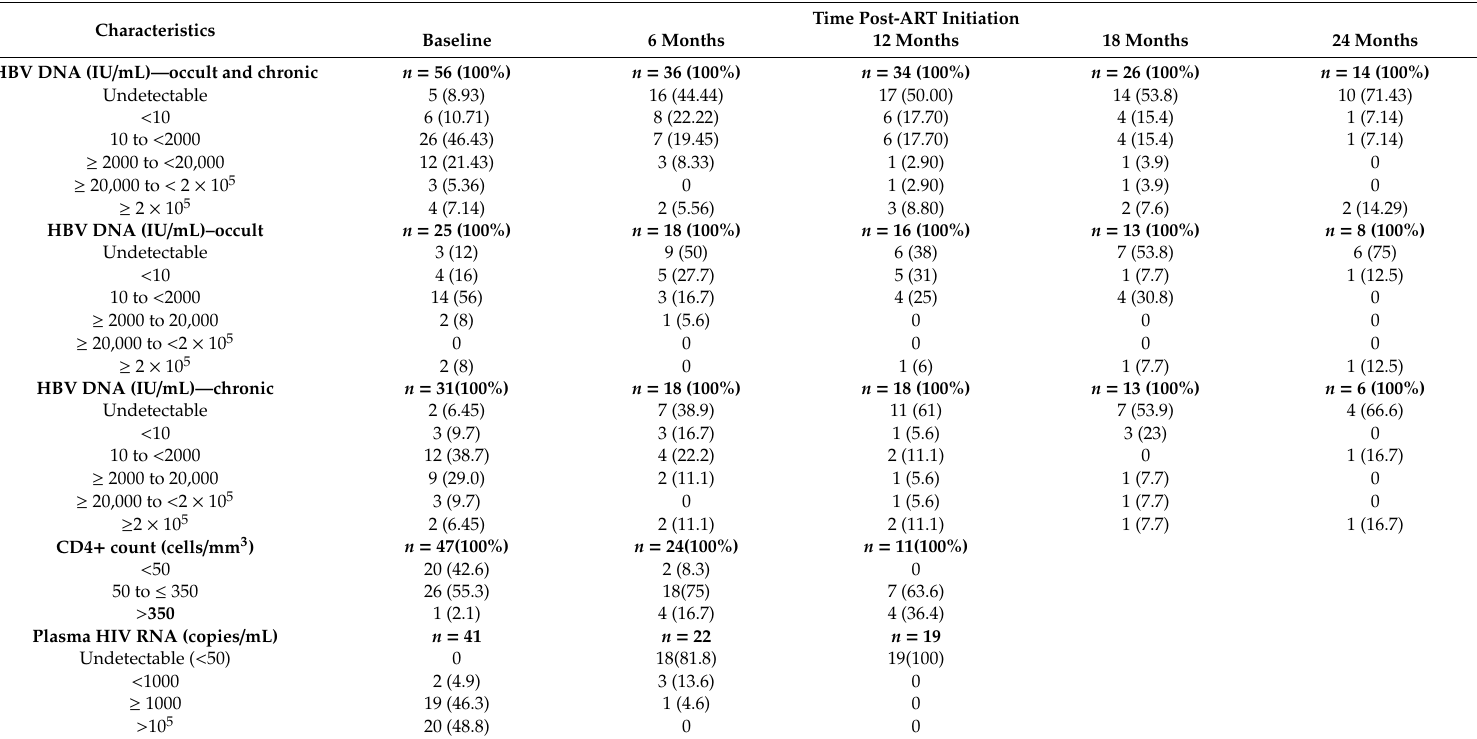
Table 2. Clinical characteristics during treatment with lamivudine-based